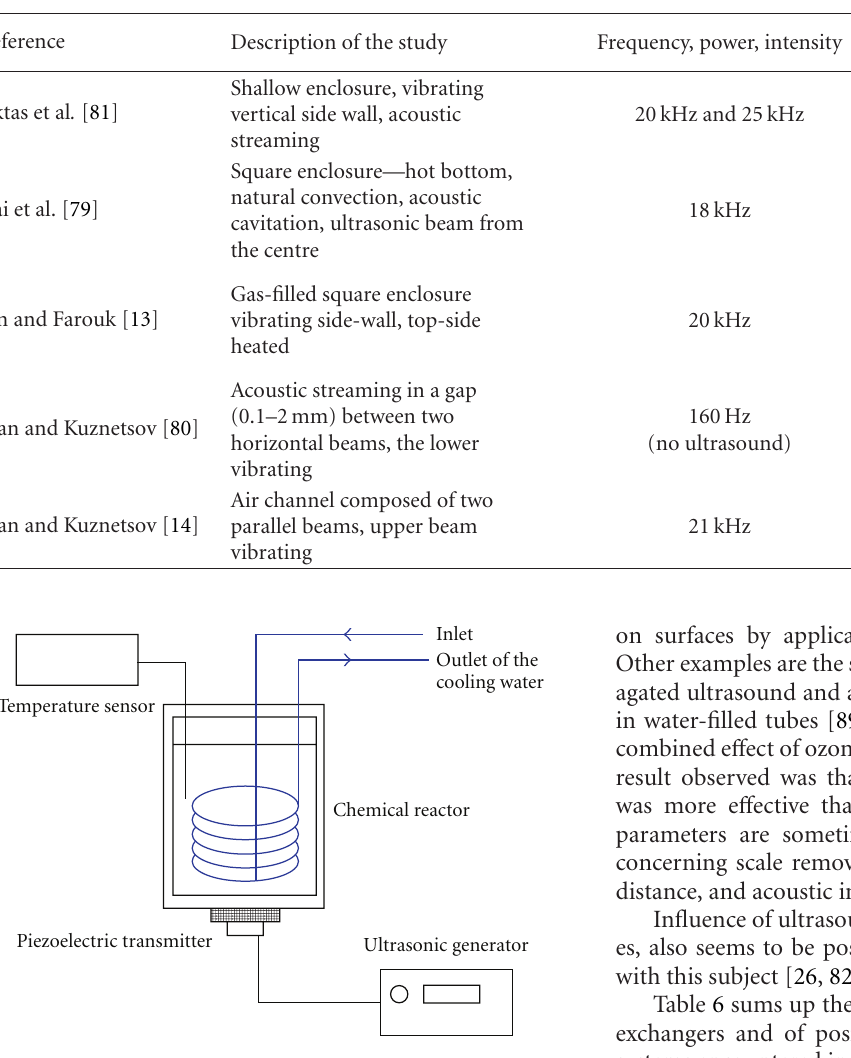
Figure 12: Ultrasonically assisted cooling of a chemical reactor.